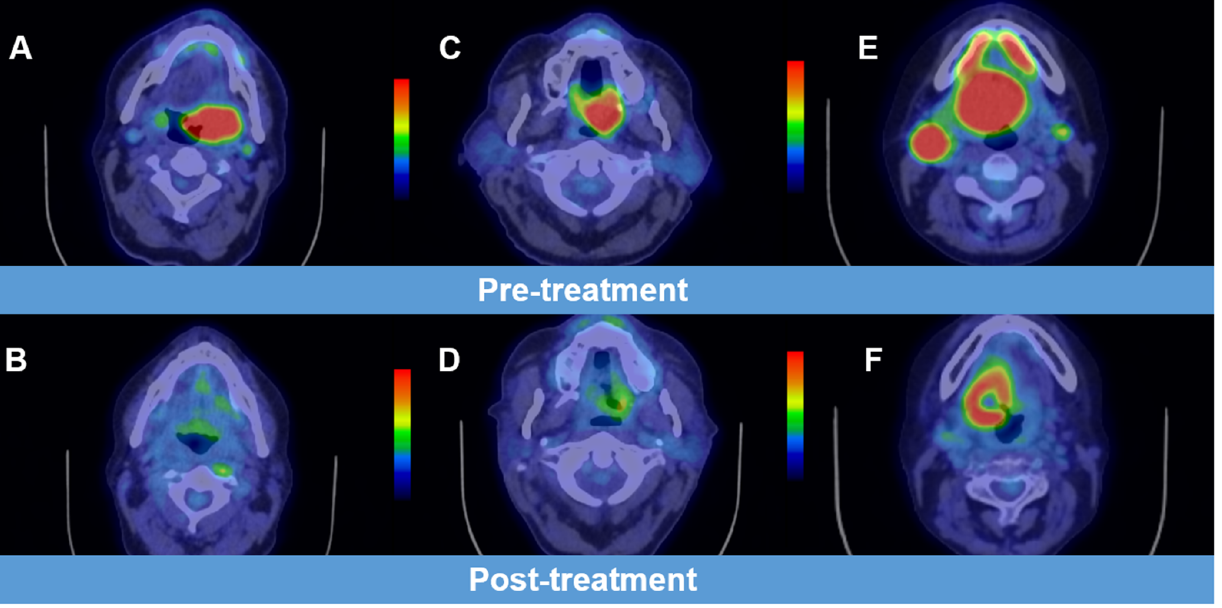
Table 2. Details of accuracy of PET-CT response scans comparing complete metabolic response versus non-complete responses.